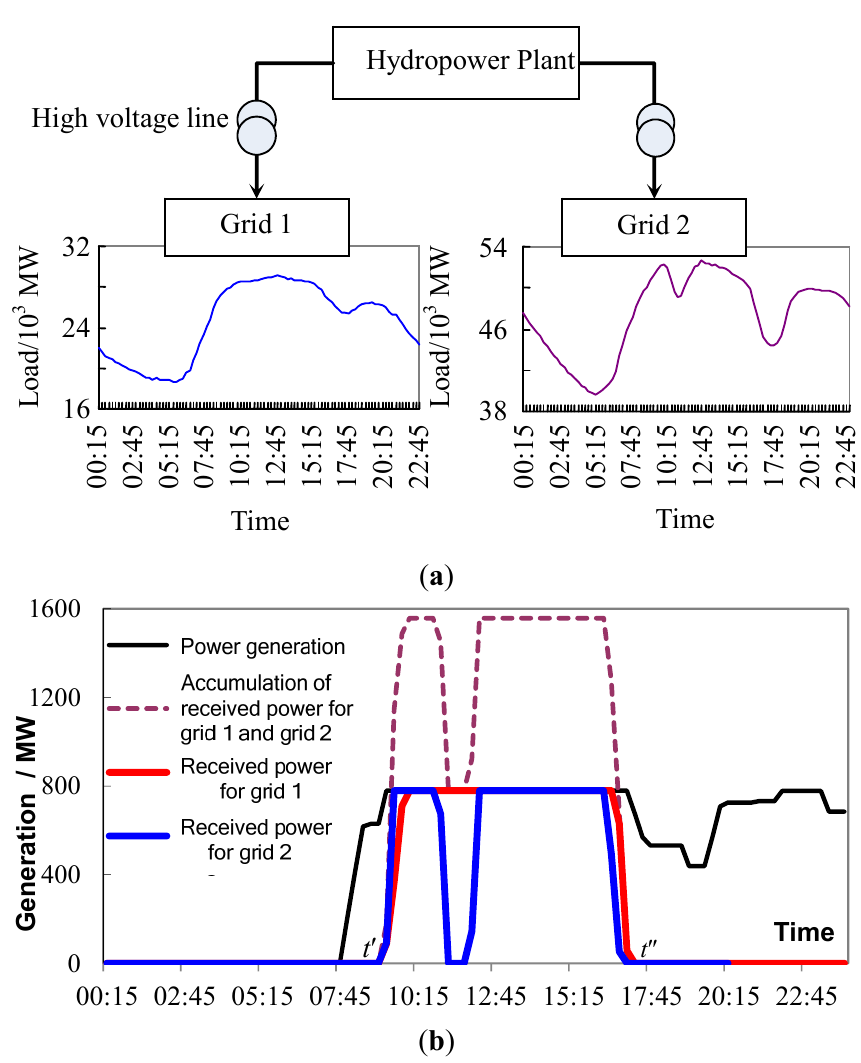
Figure 5. ( a ) A general example about power transmission via trans-provincial power network; and ( b ) initial solution for the exterior point search